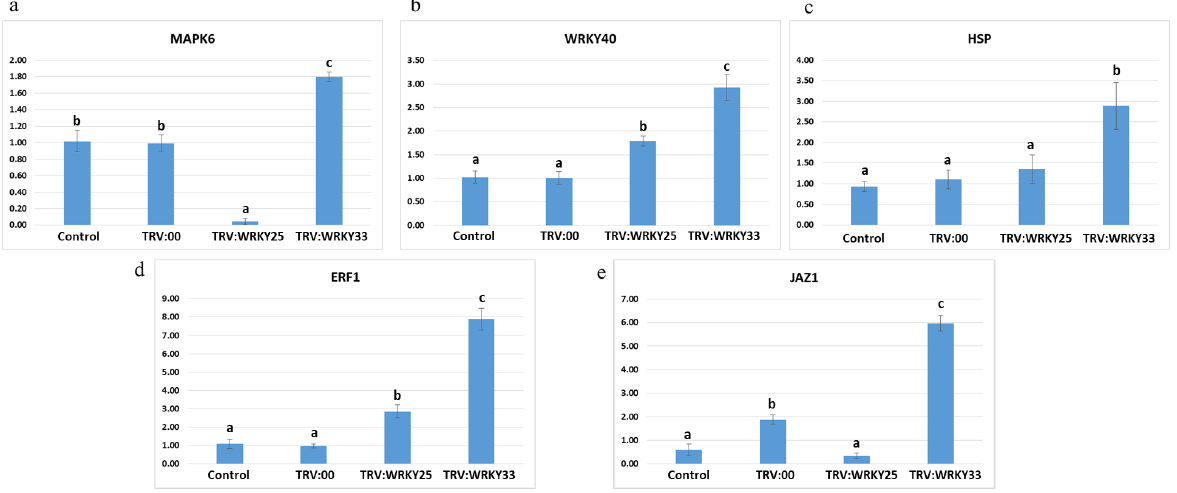
Figure 8. Relative expression analysis of MPK6 , WRKY40 , HSP , ERF1 , JAZ1 in VIGS-infiltrated cotton plants. Quantitative real-time expression of MPK6, WRKY40, HSP, ERF1, JAZ1 is shown from ( a – e ) in leaves of non-infiltrated, TRV:00-infiltrated, TRV:TRV2-WRKY25-, and TRV:TRV2-WRKY33-infiltrated cotton plants. Error bars indicate deviation between three experimental repeats, and specific letters are assigned to bars according to a standard error within replicates.